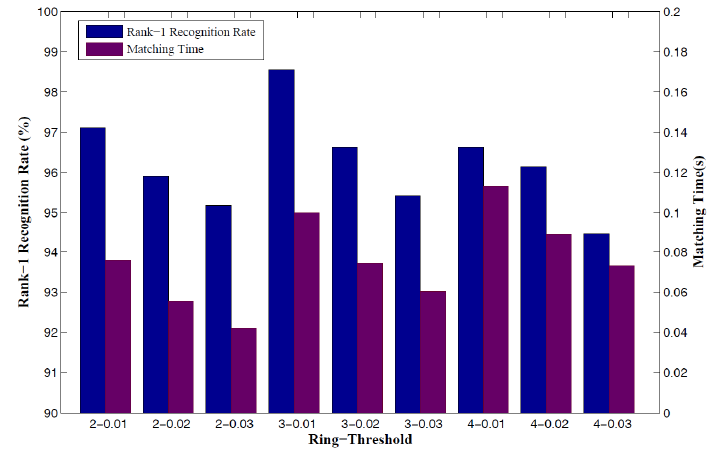
Figure 12. The recognition performance with different neighborhood sizes and thresholds.